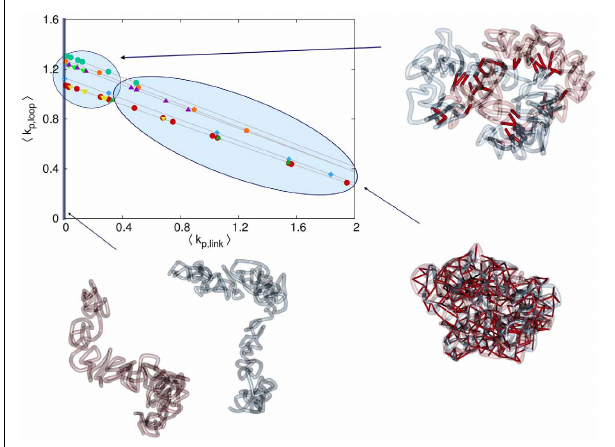
FIGURE 4 | Phase diagram for the different possible configurations. The mean concentration of interlinks between the sister fibers is denoted by (cid:3) k p , link (cid:4) and the average concentration of intrafiber cross-links is denoted by (cid:3) k p , loop (cid:4) . The different symbols in the diagram denote the different series of simulation runs. Note that the link concentrations are governed by the linking probabilities p loop , p link and the mean lifetime of links τ loop , τ link . If the probability p link that one segment of the first sister chromatid forms a link with a segment of the second sister chromatid is very small, then the rate of interlink formation is not high enough to keep the two chromatids together. Entropic forces will then drive them away from each other and consequently the interlink concentration is k p , link = 0. For very high p link or long lifetimes τ link the interlink concentration becomes so high that the two sister fibers are completely intermingled. Only in a sensitive intermediate region of interlink concentrations do the sisters segregate properly but are hold together by some interlinks preventing them to drift away from each other.